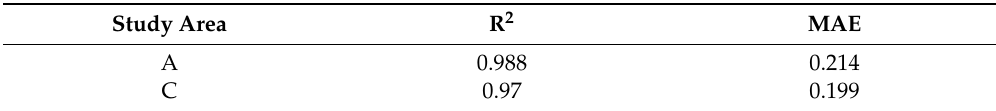
Table 4. Accuracy assessment of the WRT-WOFOST